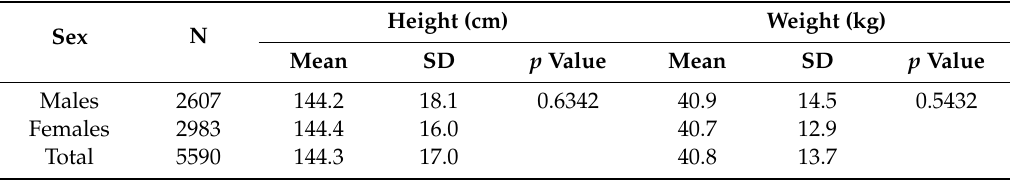
Table 1. Physical characteristics of subjects by sex.